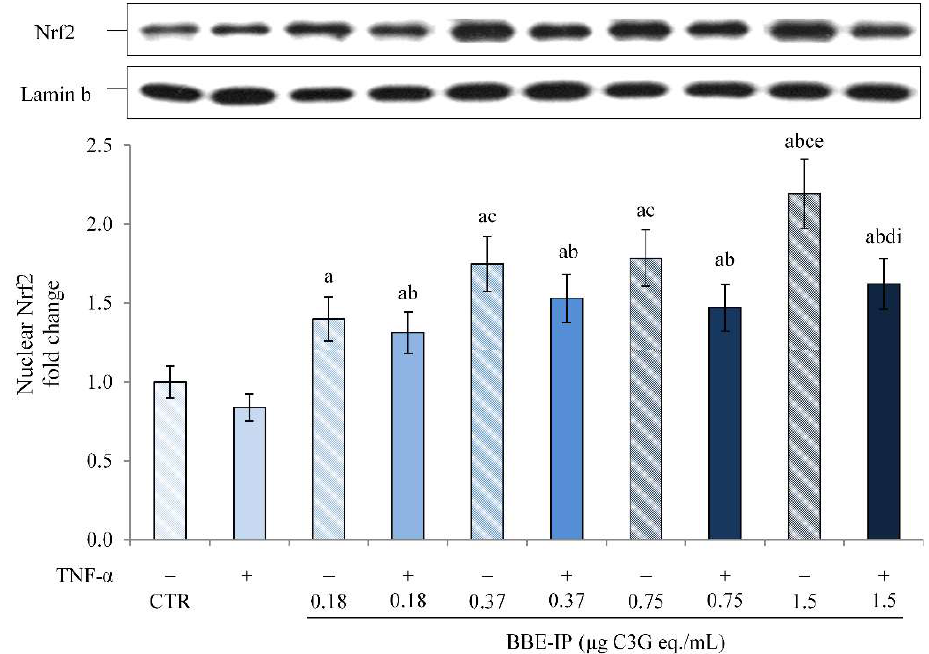
Figure 6. Nuclear Nrf2. Differentiated Caco-2 cells were pretreated or not for 24 h with different concentrations of the BBE-IP (0.18, 0.37, 0.75, 1.5 μg C3G eq./mL). Cells were subsequently exposed to 50 ng/mL TNF-α for 6 h. Cells treated with the vehicles alone were used as controls (CTR). Results are reported as fold change against CTR and expressed as mean ± SD of three independent experi- ments. Nrf2 values were normalized to the corresponding Lamin b value. a p < 0.05 vs. CTR; b p vs. TNF-α; c p < 0.05 vs. BBE-IP 0.18 unexposed to TNF-α; d p < 0.05 vs. BBE-IP 0.18 exposed to TNF-α; e p < 0.05 BBE-IP 0.37 unexposed to TNF-α; i p < 0.05 BBE-IP 1.5 unexposed to TNF-α.